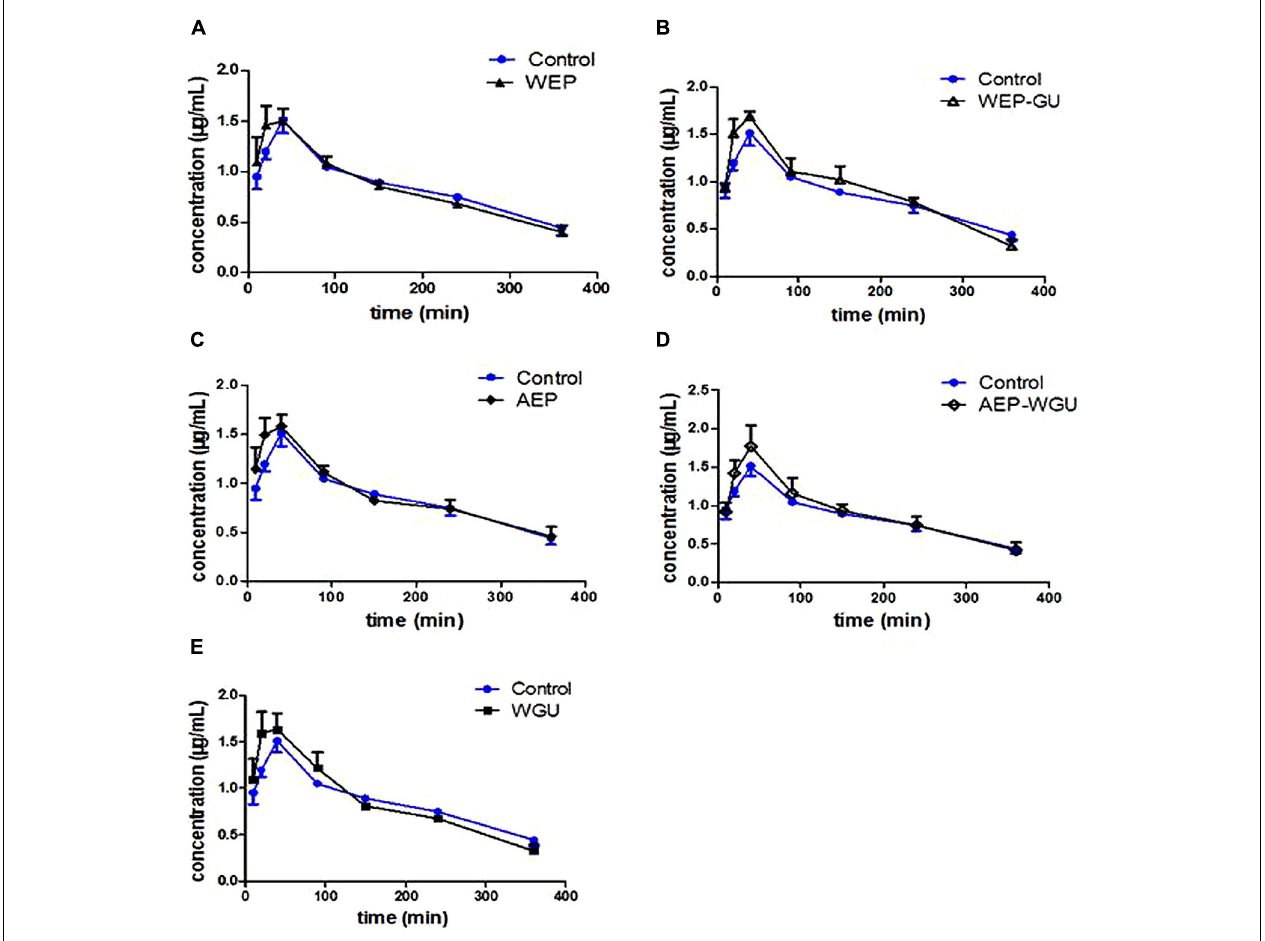
FIGURE 2 | Mean plasma concentration–time curve of 4-hydroxytolbutamide after treatment. (A) Control andWEP; (B) Control andWEP-GU; (C) Control and AEP; (D) Control and AEP-WGU; (E) Control andWGU; ( ¯ x ± s, n = 6).